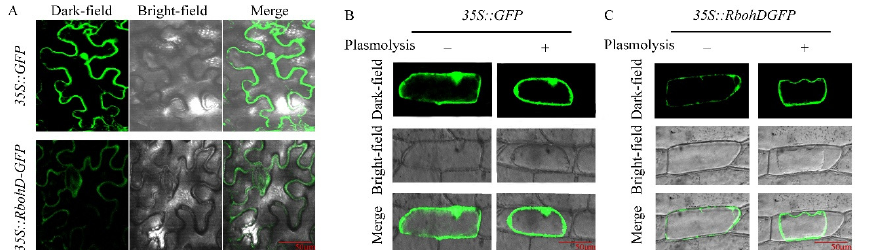
Figure 7. Subcellular localization of GhRbohD. ( A ) Subcellular localization of 35S::GhRbohD-GFP fusion proteins were transiently expressed in N. benthamiana leaves. ( B , C ) 35S::GhRbohD-GFP fusion proteins were transiently expressed in onion epidermal cells. The signal was visualized with confocal microscopy. Scale bar = 50 μ m.